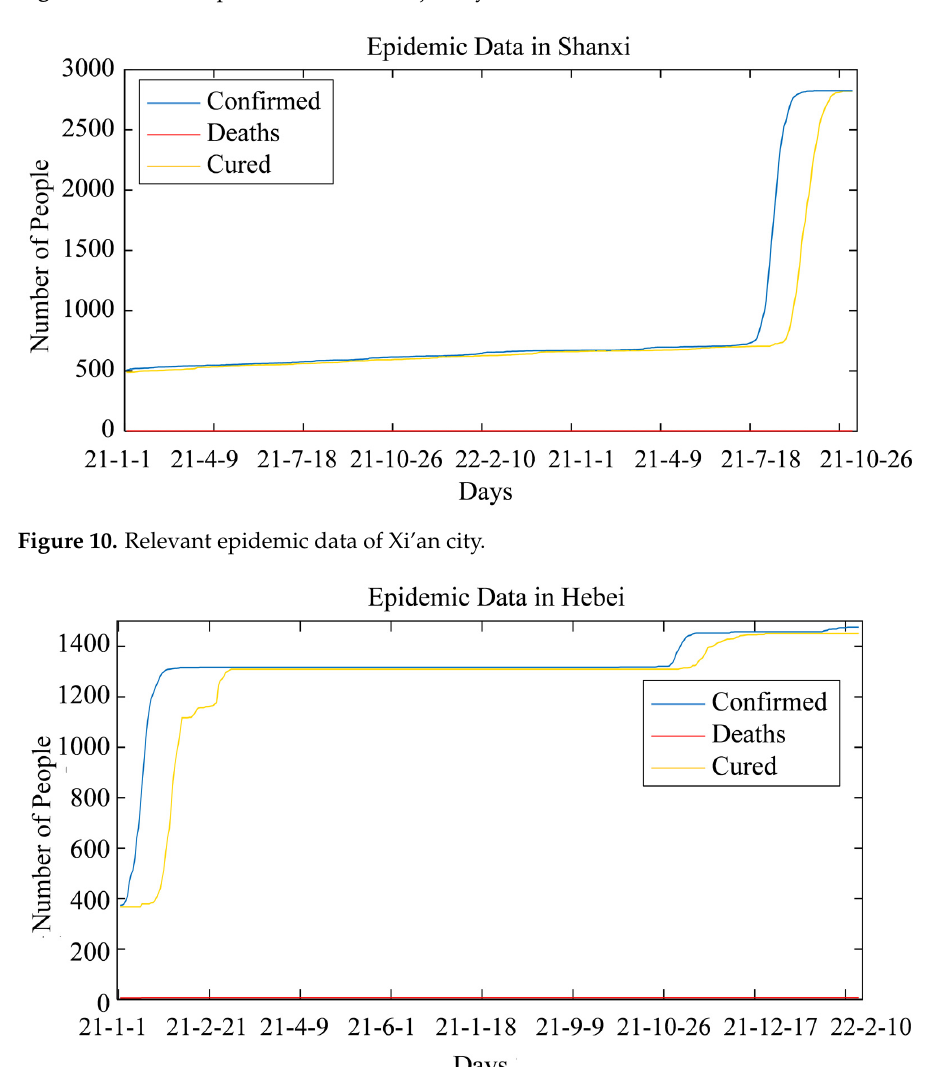
Figure 9. Relevant epidemic data of Tianjin city.